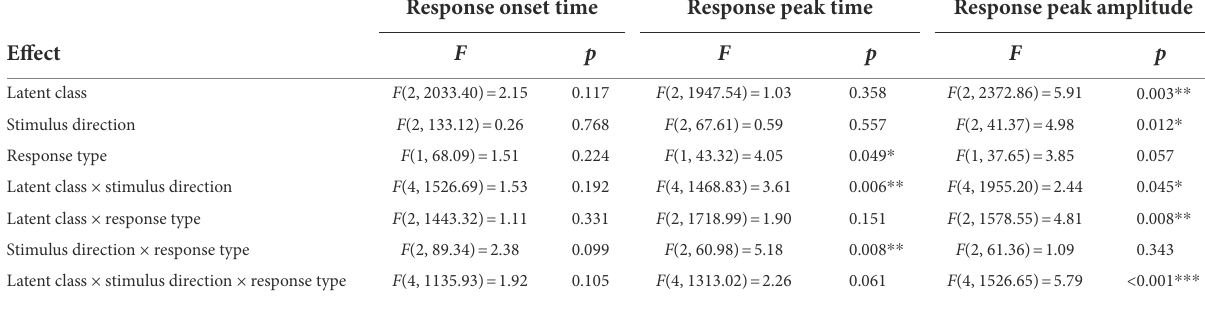
TABLE 5 Summary table of the linear mixed-effects models on response onset time, response peak time, and response peak amplitude.